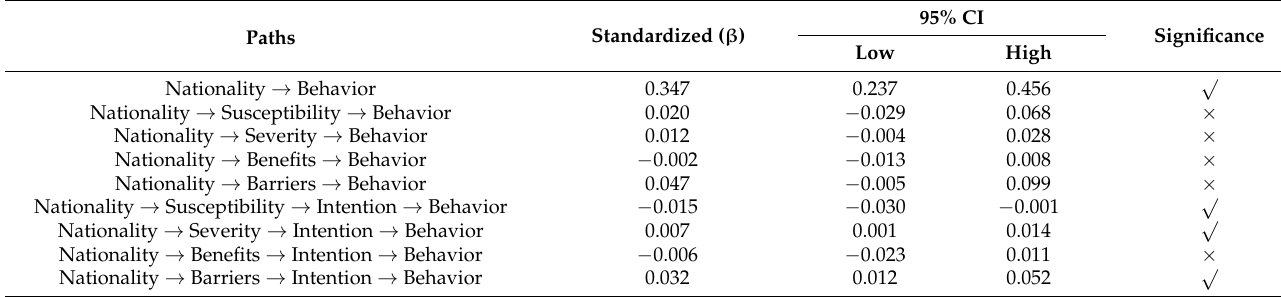
Table 4. Bias-corrected bootstrap tests on the direct and indirect effects. Paths Standardized ( β